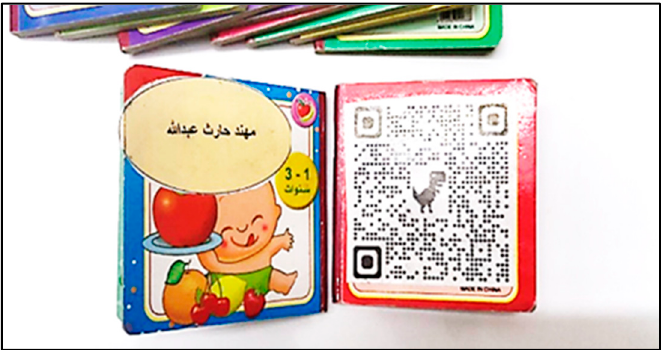
Figure 5. Fun ‐ Book Brochure . Figure 5. Fun-Book